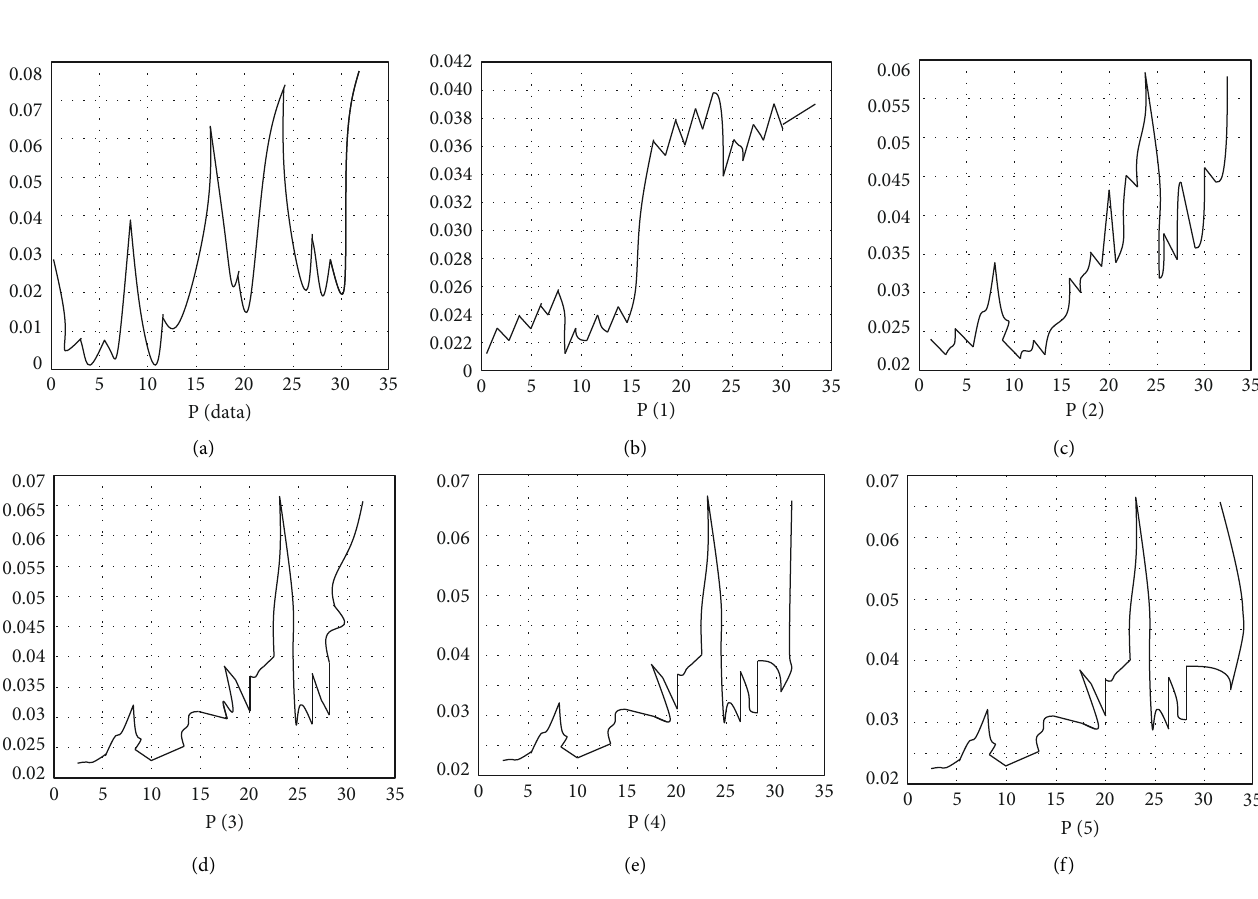
Figure 2: Test process and test data probability.